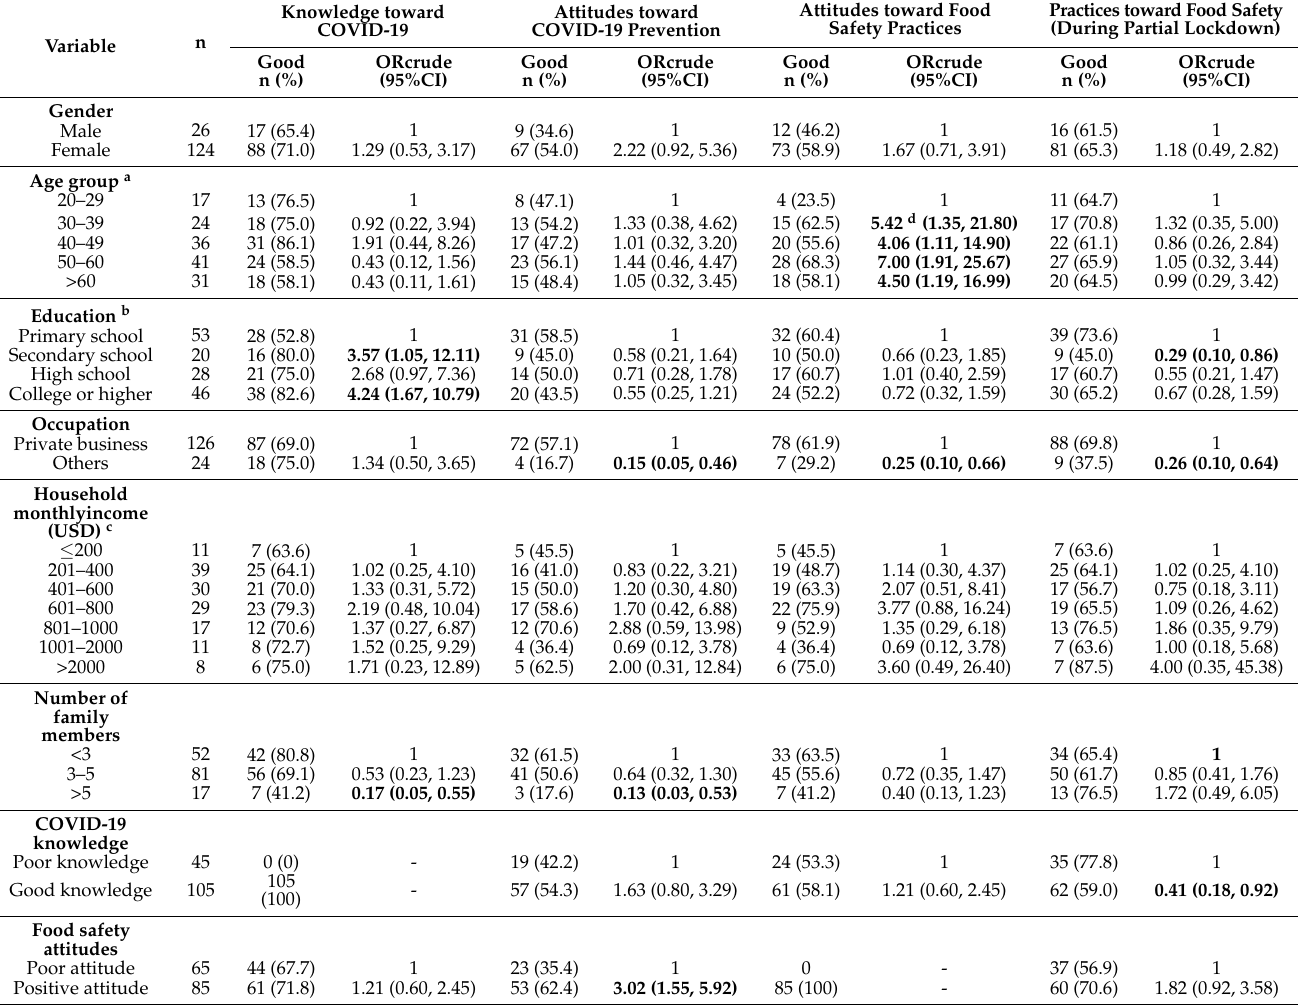
Table 3. Univariable analysis of the knowledge, attitudes, and practices of